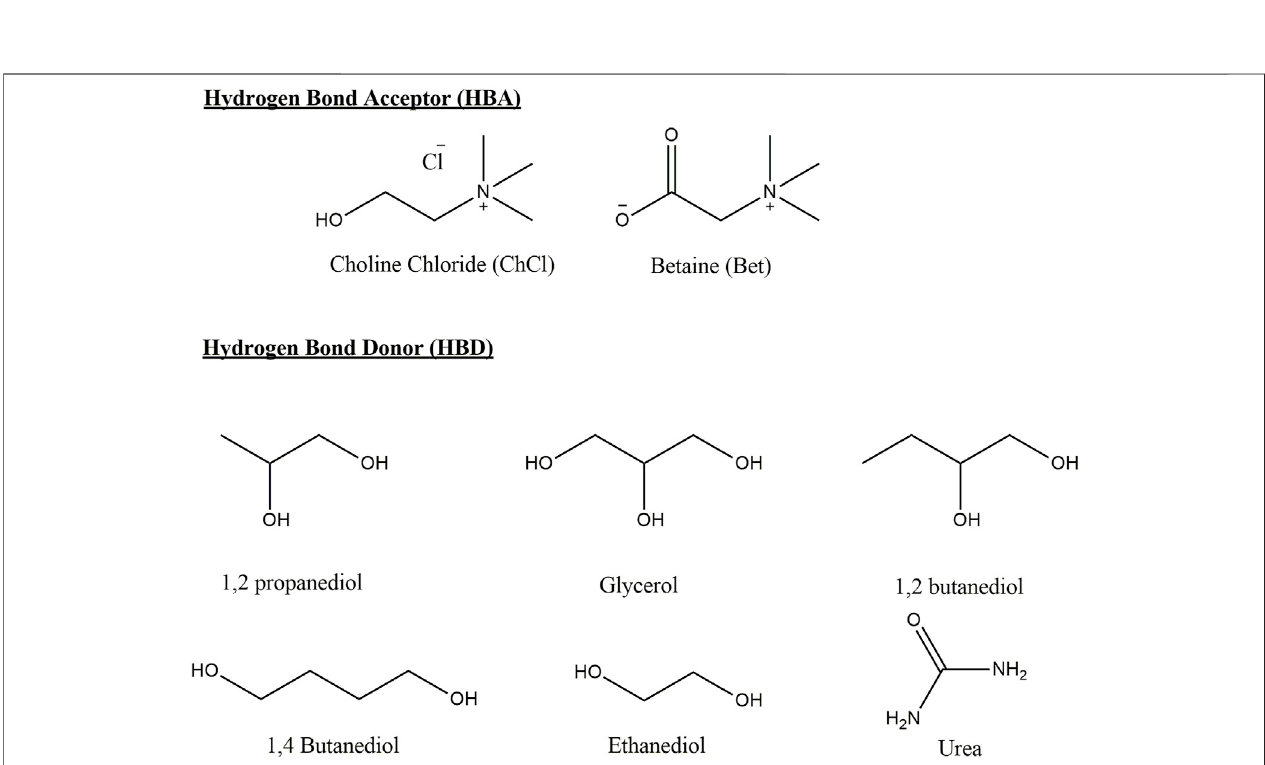
FIGURE 2 | Structures of HBA and HBD of DES and the acronyms used in this study.